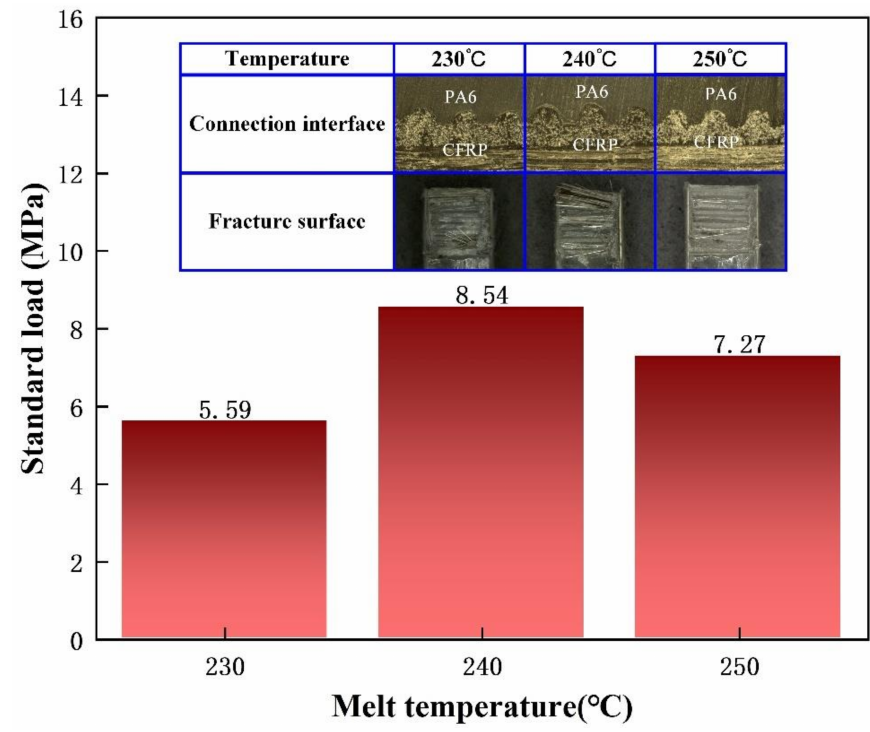
Figure 7. Effect of melt temperatures on the tensile strength of the composite